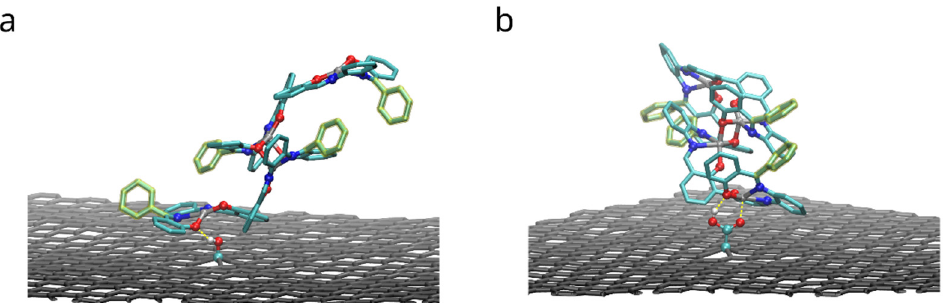
Figure 12. Configurations with the highest adhesion free energy for the dimers of the compound A with functional phenyl groups adsorbed on the surface of graphene functionalized with hydroxyl ( a ) and carboxyl groups ( b ). Only upper graphene layer is shown and solvent molecules and compounds hydrogens are omitted for clarity. Yellow dashed lines highlight hydrogen bonds and carboxyl oxygen interaction with zinc.